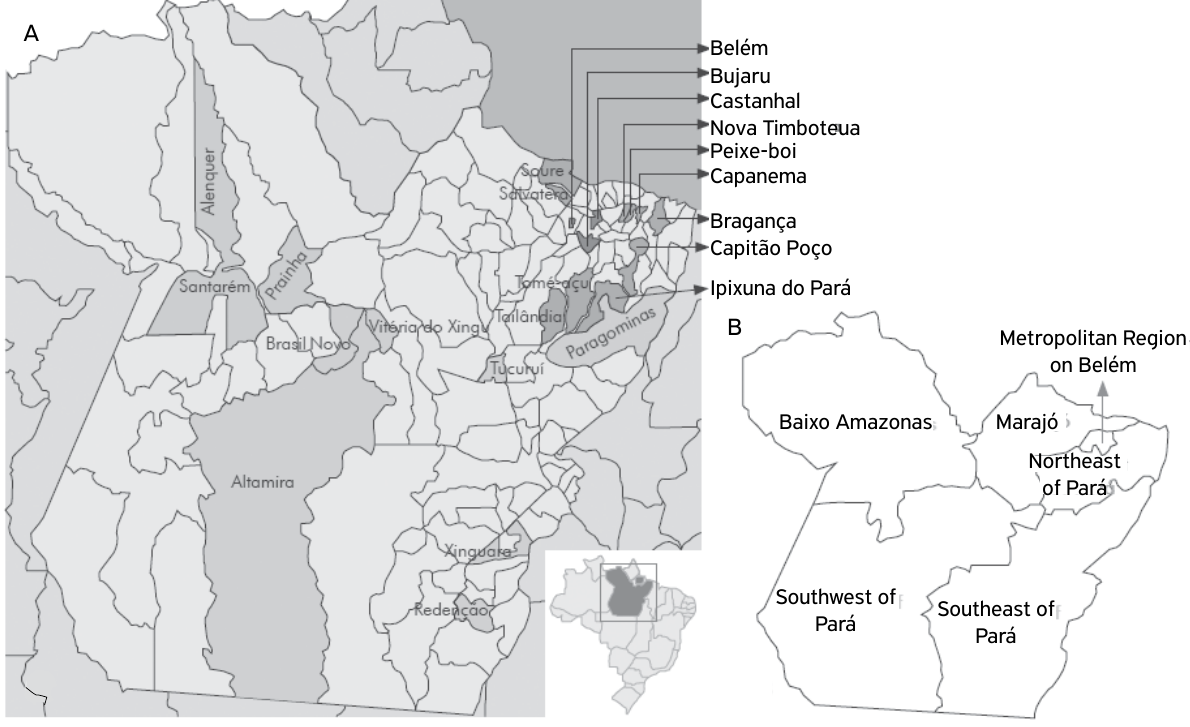
Figure 1. Schematic representation of the Pará State indicating were collected from the domestic herbivores serum samples. (A) Collecting municipalities, (B) The division into mesoregions of